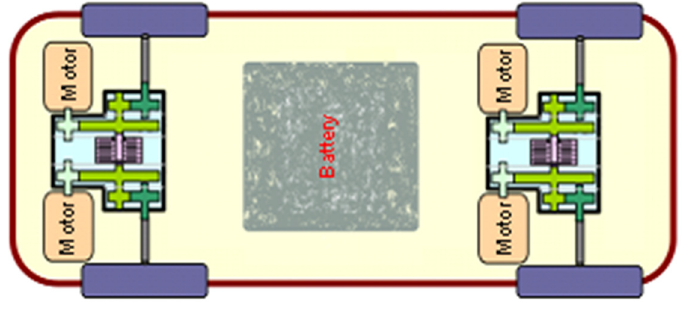
Figure 1 . Drive system structure of the nominal